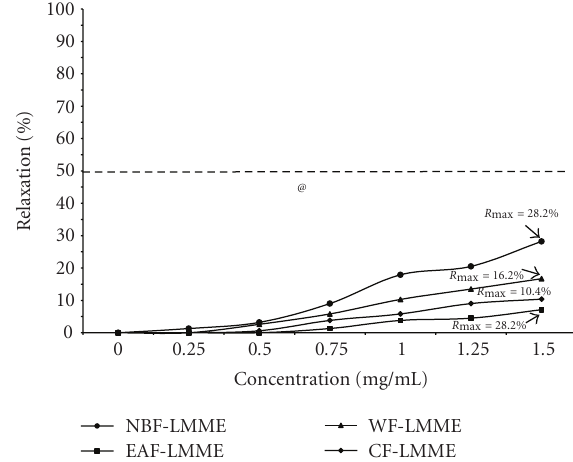
Figure 2: Median inhibitory concentration of and relaxation response to Loranthus micranthus methanolic extract (LMME) frac- tions by rat aorta rings precontracted with KCl. WF-LMME = Water fraction; NBF-LMME = n-butanol fraction; CF-LMME = Chlororform fraction; EAF-LMME = ethyl acetate fraction @ P = 0 . 004 Multivariate test of mean R max values of the four